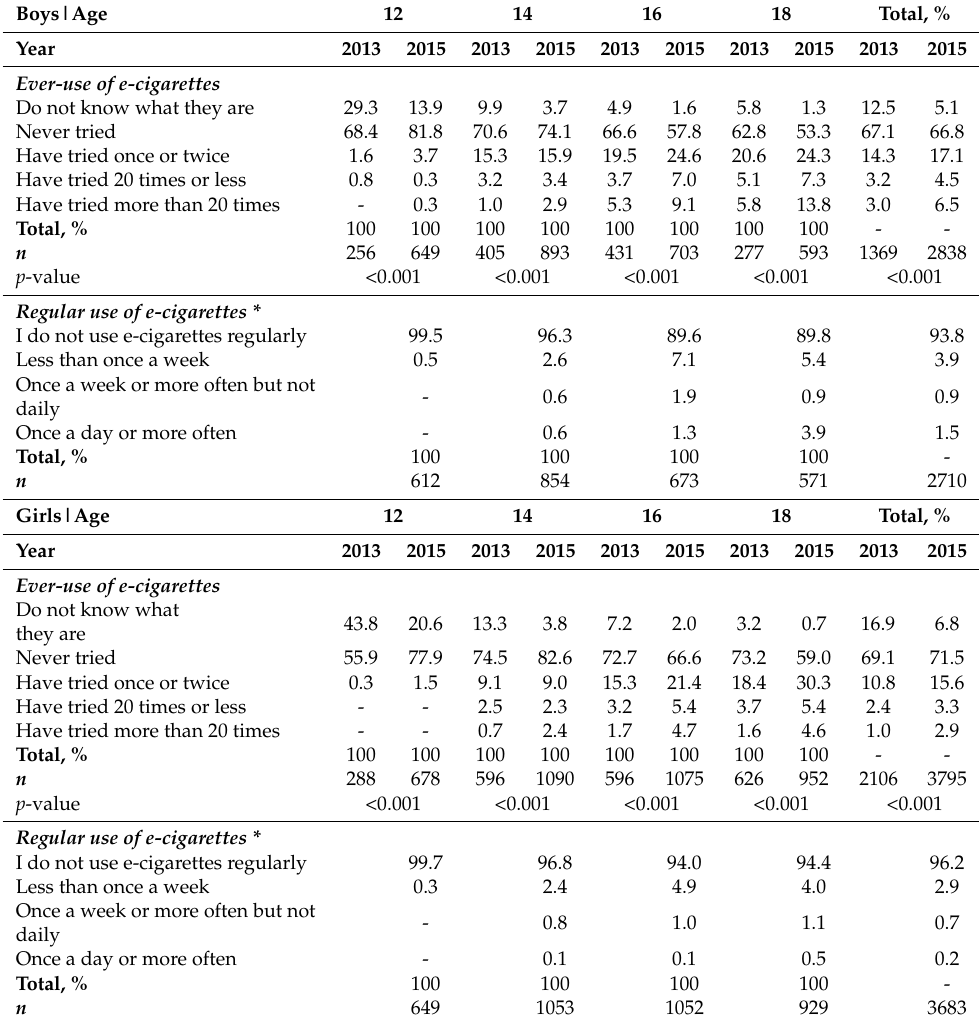
Table 1. Distribution of e-cigarette experimentation among adolescents in Finland in 2013 and 2015 and p -value for differences between years, and regular use in 2015, by gender and age, %. The total columns are adjusted for